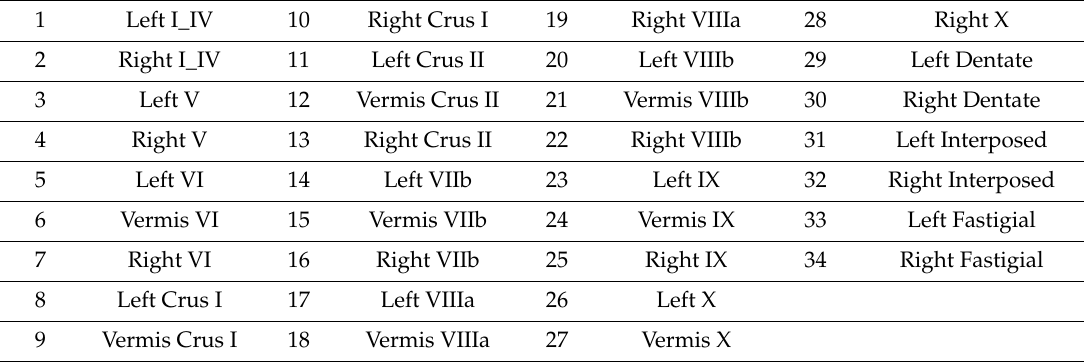
Table A1. The 34 SUIT labels